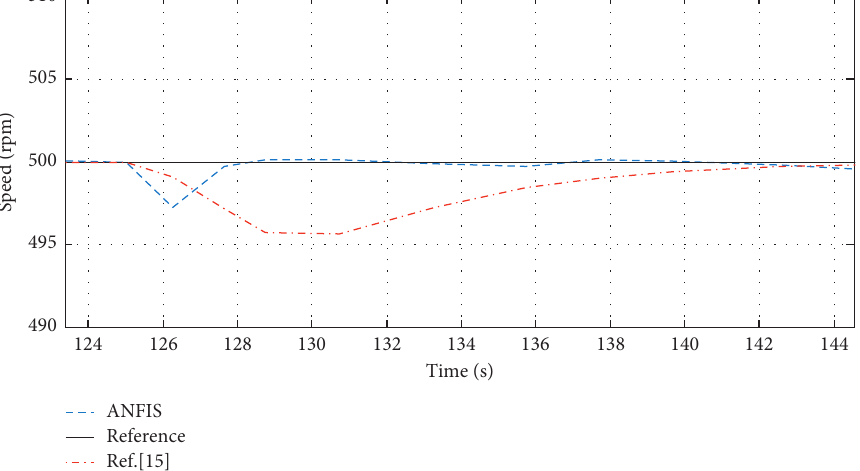
Figure 22: Magnification of Figure 21 at t �